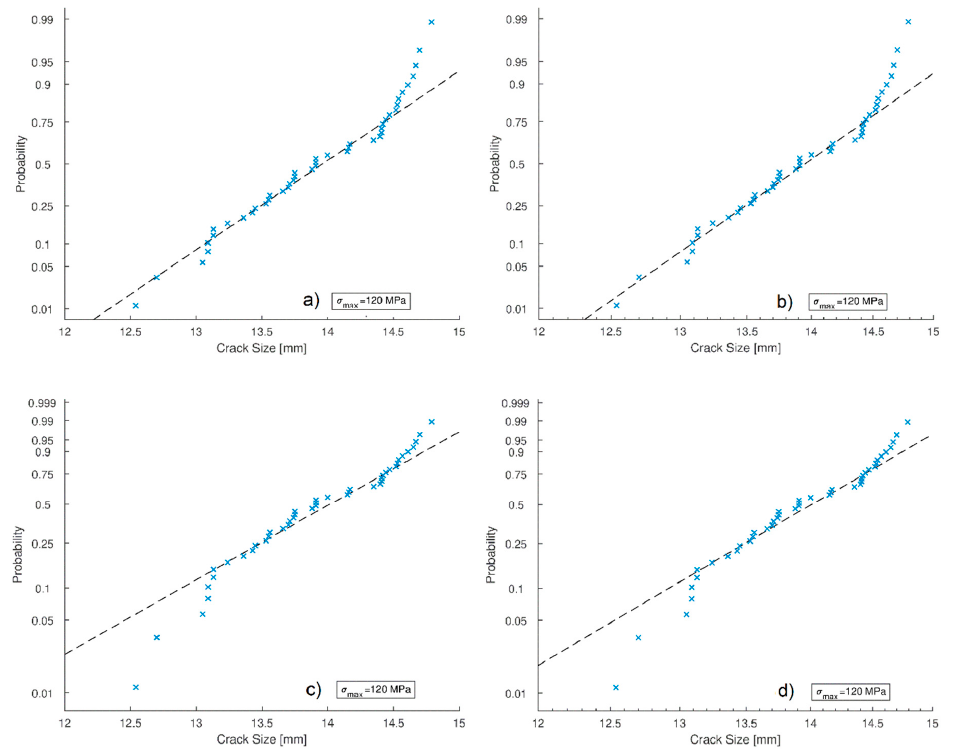
Figure 12. Critical crack size at 120 MPa: probability plots for normal ( a ), log-normal ( b ), extreme value ( c ) and Weibull ( d ) distributions.